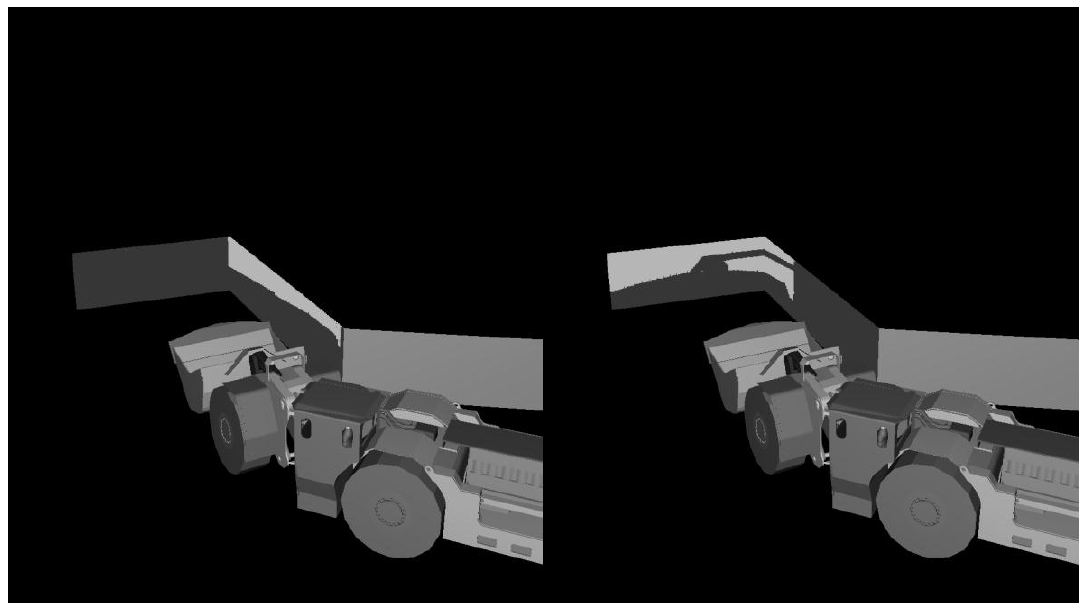
Figure 7. LHD in a 60° drift articulated 38.6° with operator line of sight ( left ) and maximum camera visibility ( right ) on planes 1 and 2 (light area = LOS, dark area = no LOS).